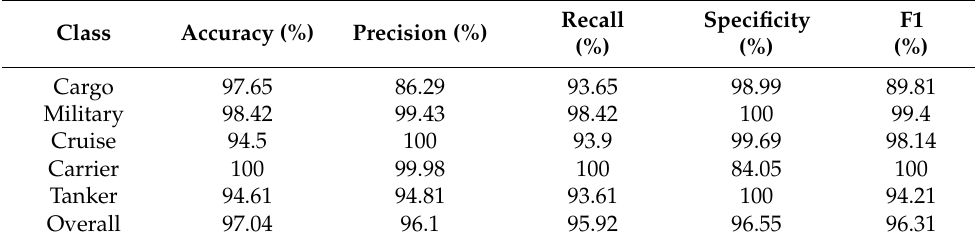
Table 7. Classification performance for the MARVEL dataset.